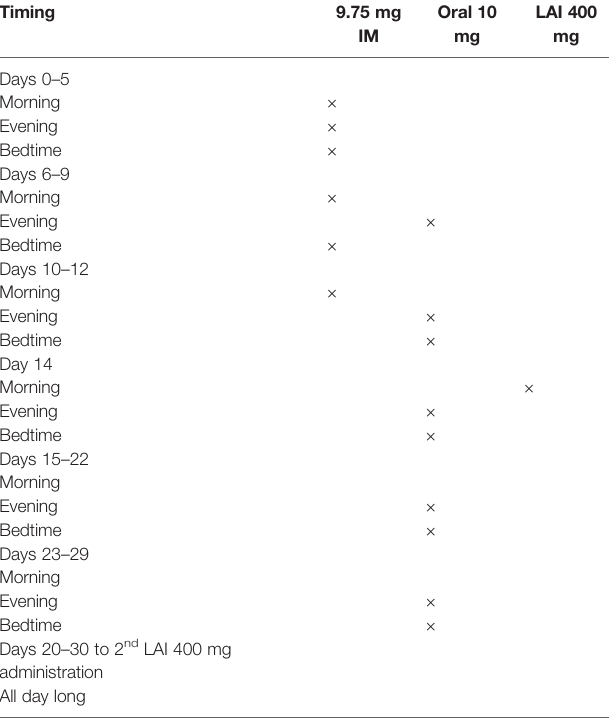
TABLE 6 | Intramuscular and oral aripiprazole administration to acutely agitated patients with psychosis.